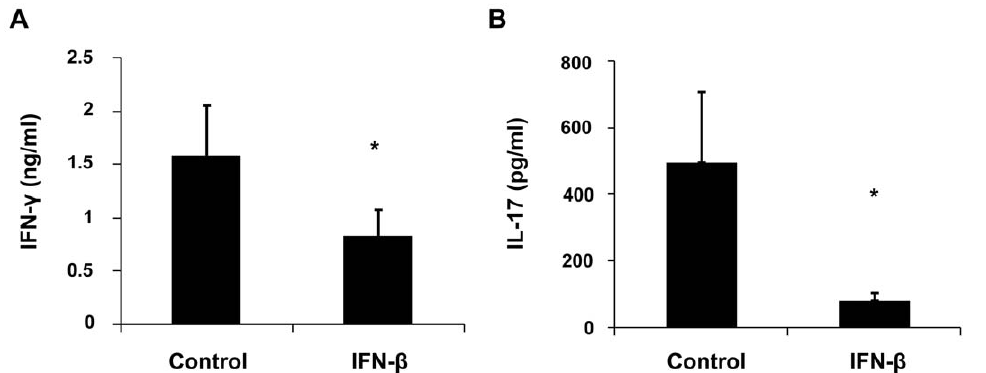
Figure 5. Effect of IFN- b on the expression of IFN- c and IL-17 by effector/memory T cells. Effector/memory T cells were cultured with or without IFN- b for 72 hours. Cytokines were detected by ELISA. Data are representative of three independent experiments. *p , 0.05.